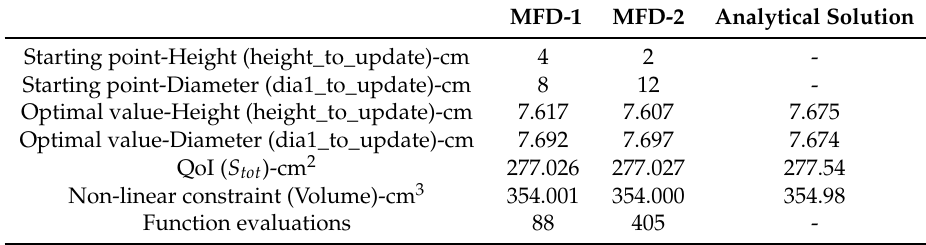
Table 1. Outcome of the optimization study using a gradient-based method (MFD